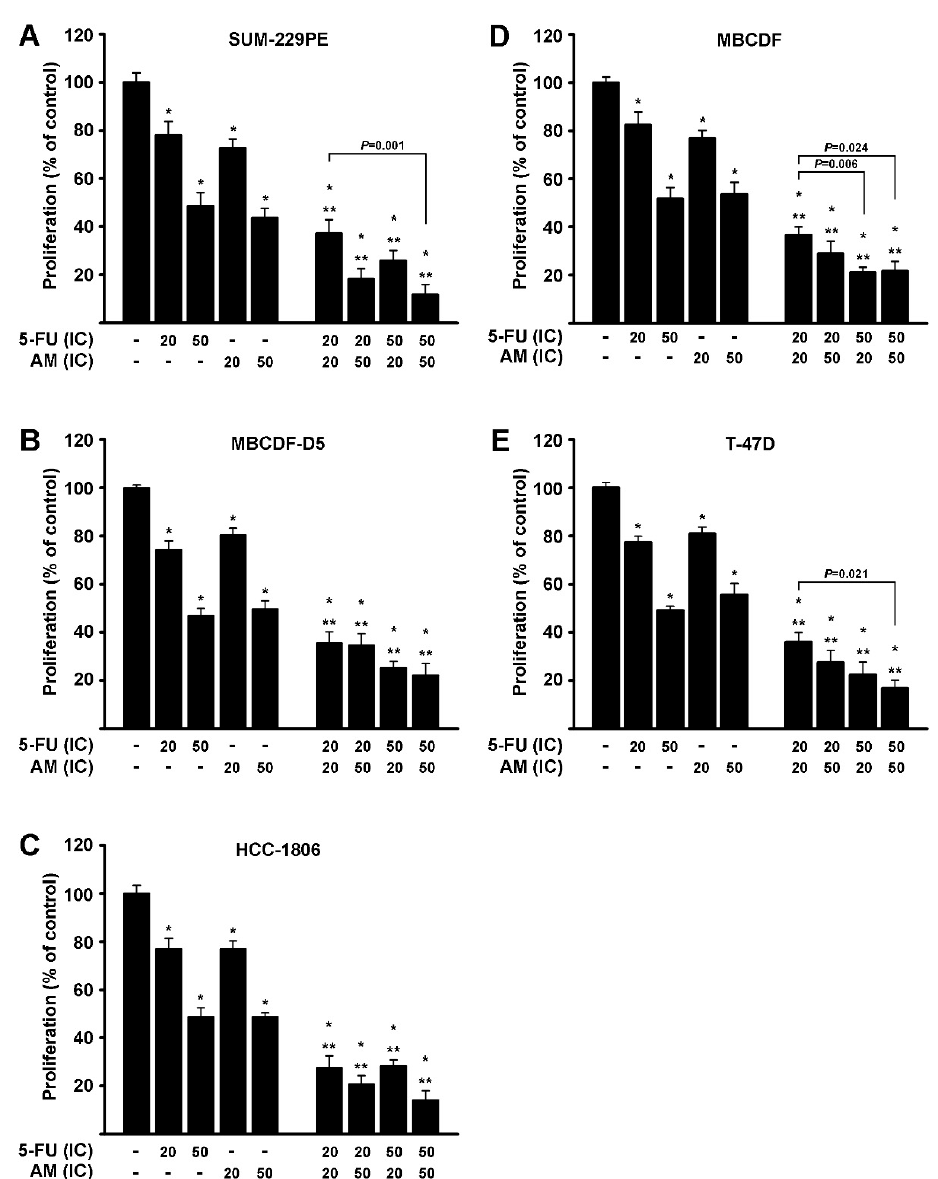
Figure 2. The combined treatment inhibited cell proliferation in a greater extent than each compound alone. The antiproliferative effect of the respective inhibitory concentrations (IC) at 20% and 50% of 5 ‐ fluorouracil (5 ‐ FU) and α‐ mangostin (AM) per se or in combination was evaluated in a panel of breast cancer cell lines. Results are depicted as the mean ± SEM of six replicates in at least three independent experiments. Data from vehicle ‐ treated cells were normalized to 100%. * P ˂ 0.001 vs. control, ** P ˂ 0.001 vs. monotreatment (5 ‐ FU or AM alone).